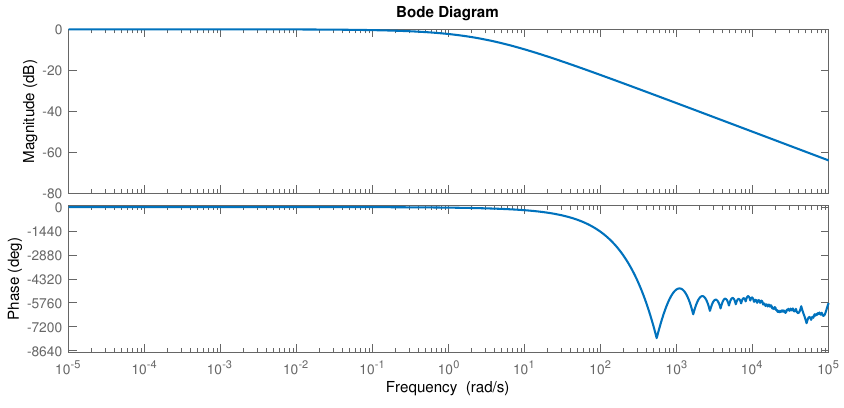
Figure 2. The bode diagrams of the system (62). The svf parameters are chosen respectively as: (cid:118) = 2 rad/s and η =